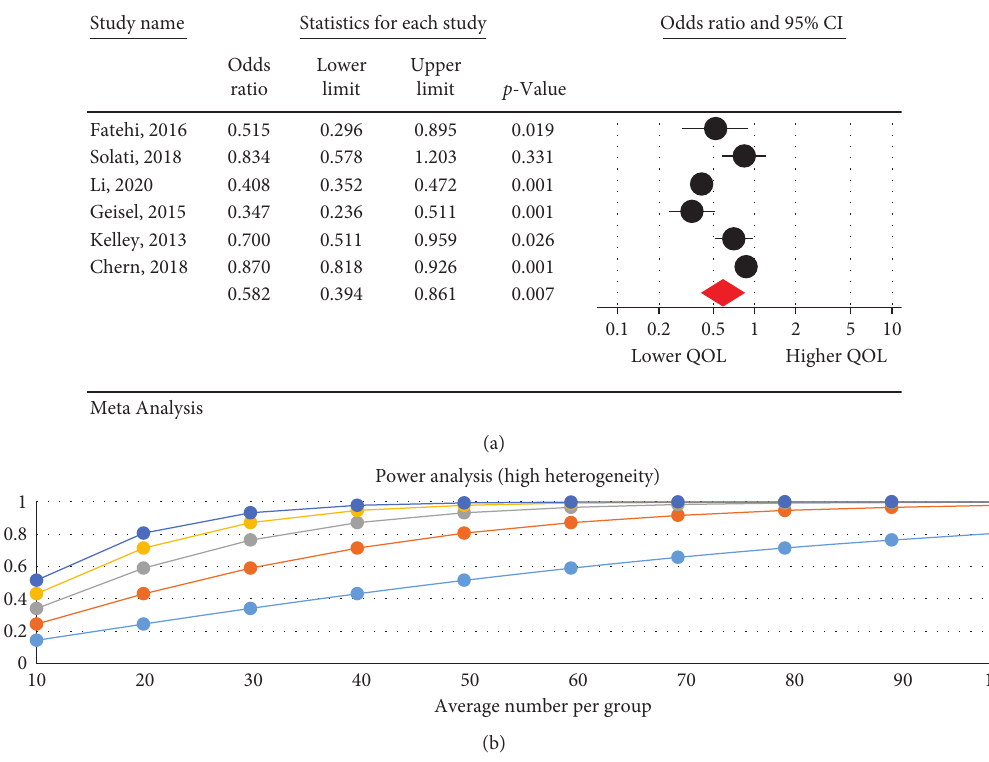
Figure 4: The relationship between the severity of internet addiction and the quality of life in the physical